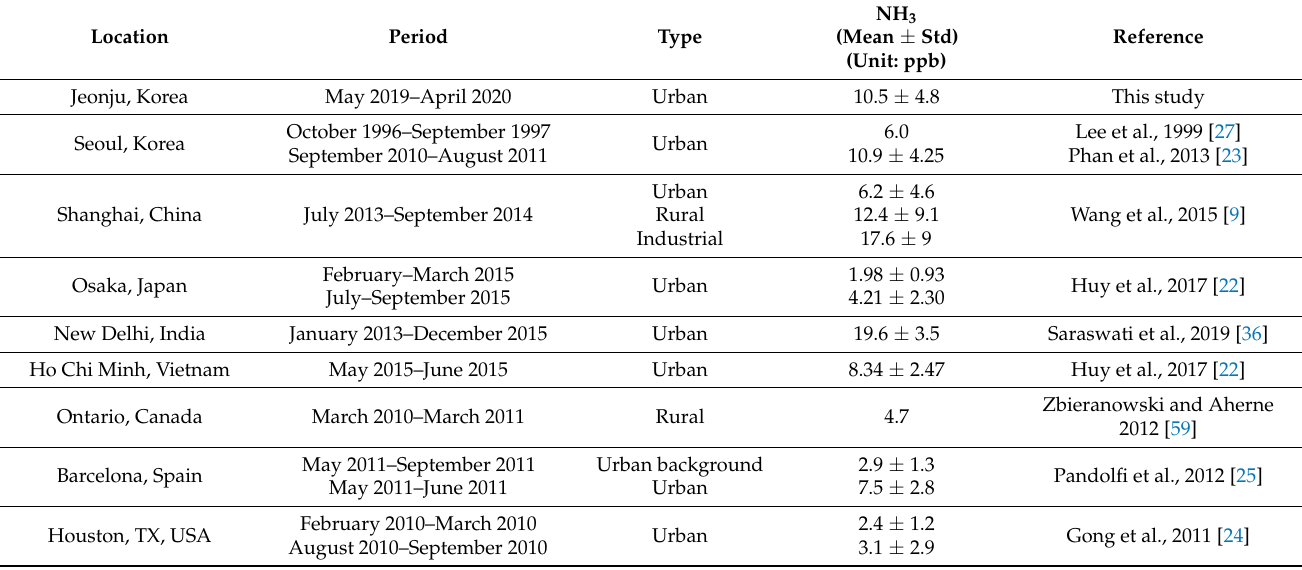
Table 1. Concentrations of atmospheric NH 3 in various